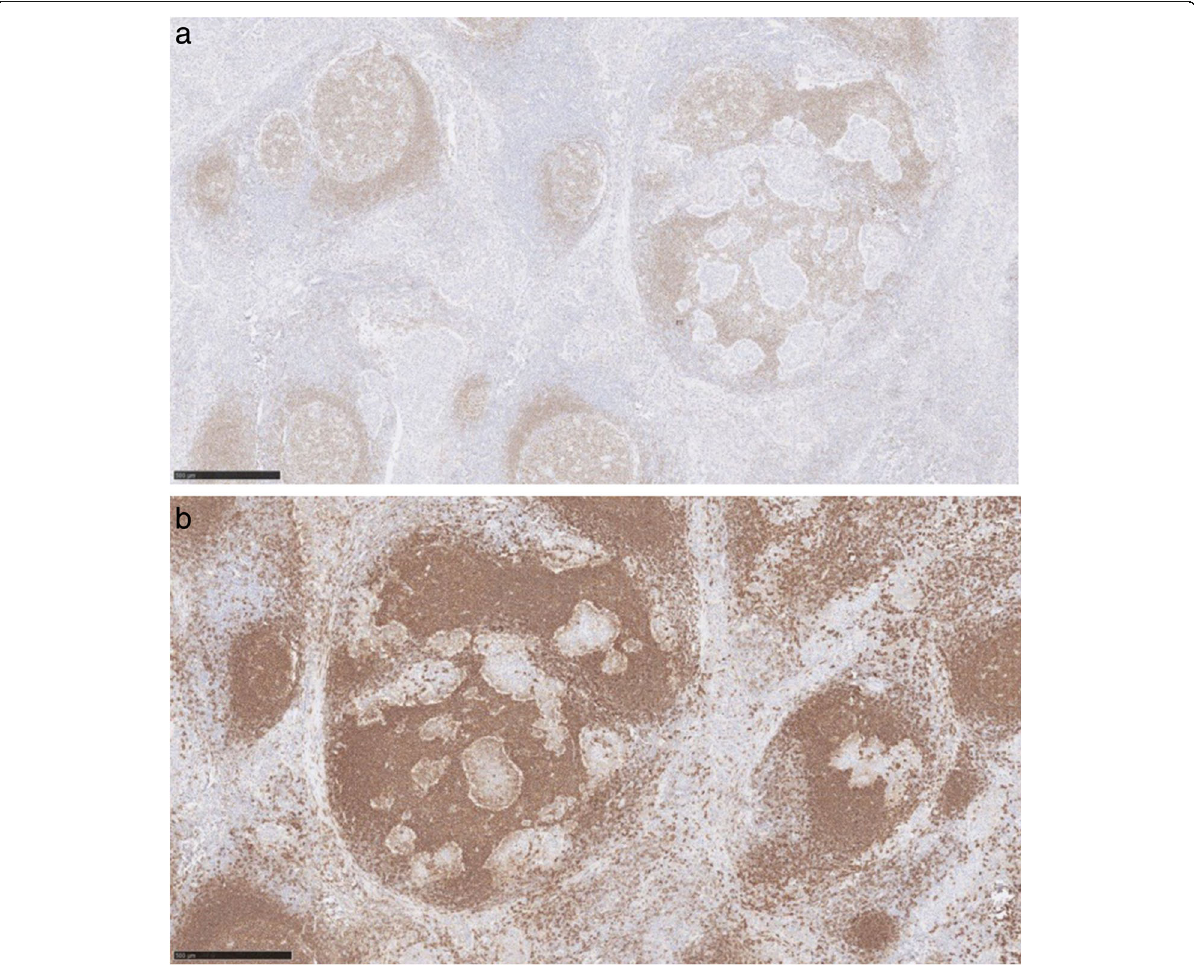
Fig. 6 Immunohistochemistry PAX-8 (left) showing the lymphoid follicles with germinal centres and CD20 (right) showing background B lymphocytes with germinal centres. Both images are ×5